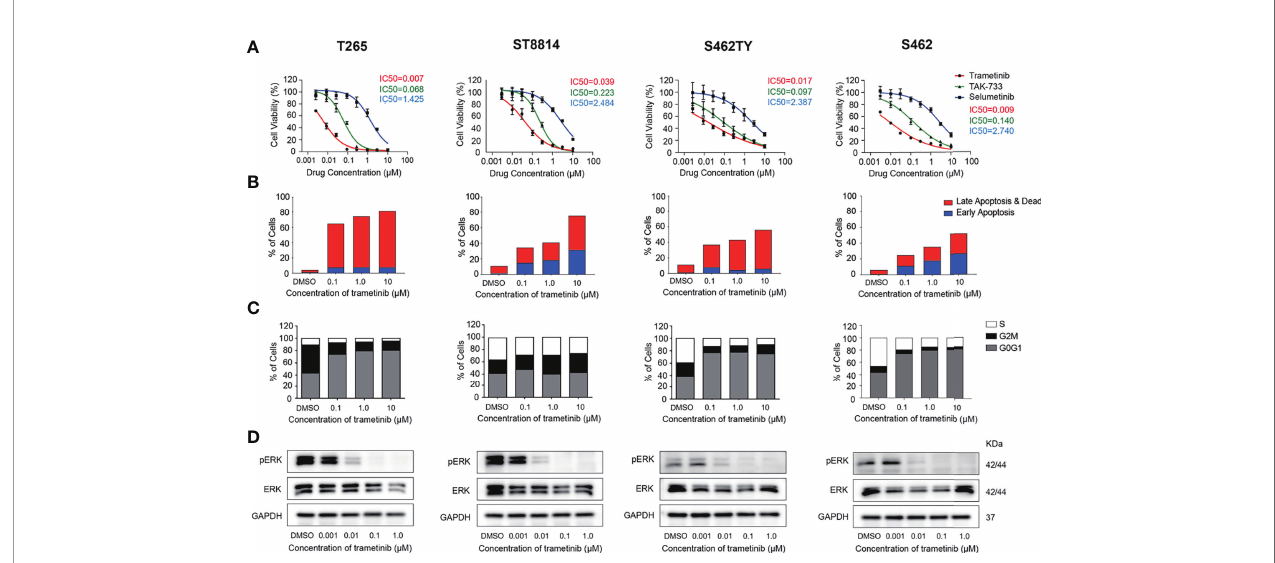
FIGURE 4 | Inhibition of p-ERK induced cell cycle arrest and apoptosis in MPNST cells. (A) Cell viability of MPNST cell lines T265, ST8814, S462, S462TY, and Schwann cell line 02.3 2 l treated with MEK inhibitors for 72h. (B) apoptosis ratios of MPNST cell lines treated with MEK inhibitor trametinib for 48h. (C) Cell cycle and (D) p-ERK/ERK expression levels of MPNST cell lines treated with MEK inhibitor trametinib for 24h.